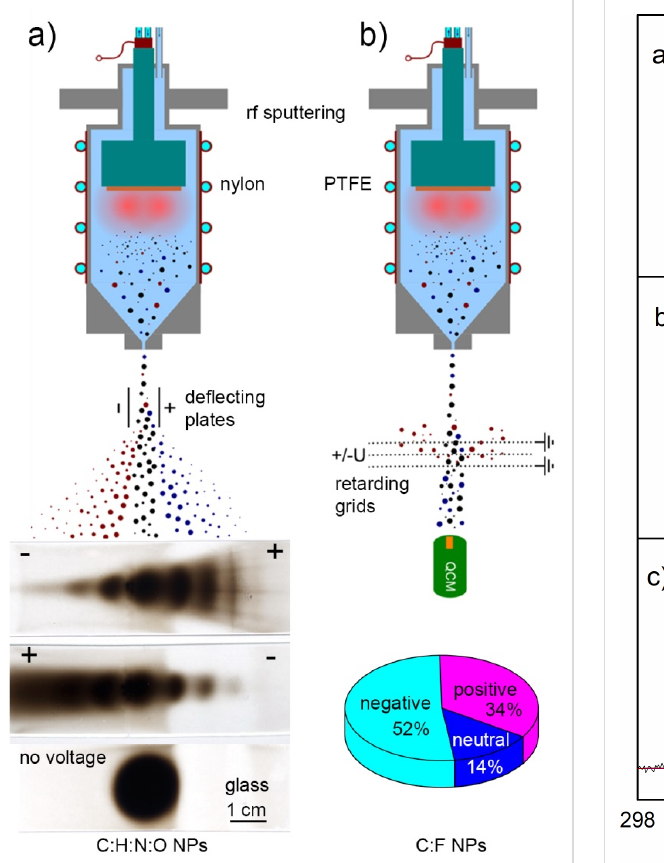
Figure 3: Experimental arrangements allowing estimation of plasma polymer NP charging: a) electrostatic plates used for deflection of charged nylon-sputtered NPs [66] by applying 200 V voltage of differ- ent polarity across the NP beam; b) electrostatic grids used for retarda- tion of charged PTFE-sputtered NPs by applying 1000 V voltage of dif- ferent polarity along the NP beam (obtained in a similar manner as [55]).